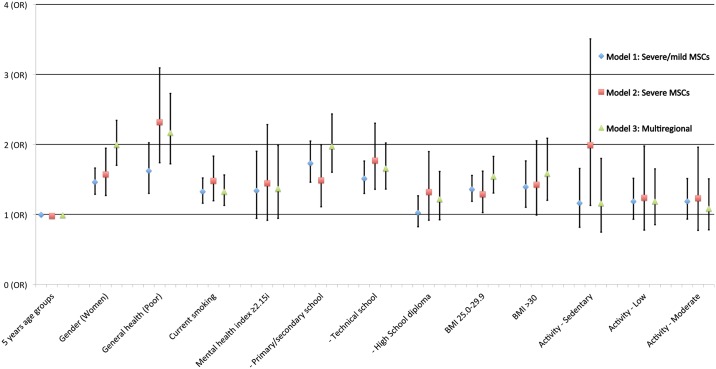
Graphical presentation of the relationship1 between health determinants and MSCs2.The Tromsø study3. 1Graphical presentation of multivariable logistic regression models, 2Musculoskeletal complaints (pain and/or stiffness in muscles and joints for 3 consecutive months during the past years); Model 1: MSCs = severe/mild versus no MSCs, model 2: MSCs = severe versus no and mild MSCs, model 3: MSCs in ≥3 body regions versus < 3 body regions, 3 A prospective cohort study of an arctic general population through 13 years consisting of 4,496 adult men and women free of MSCs at baseline.